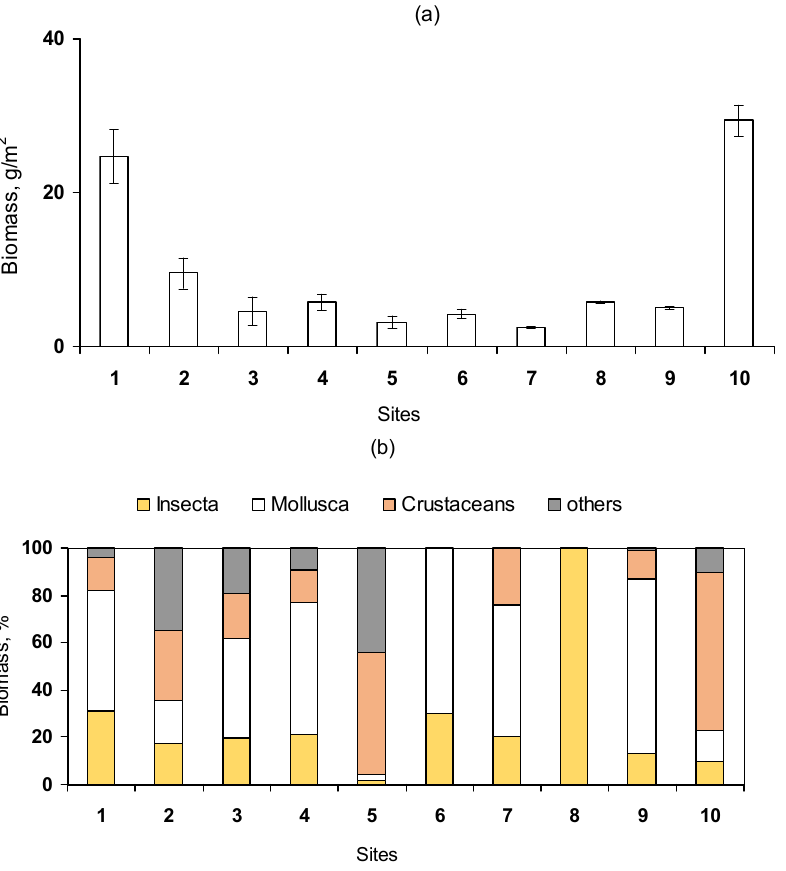
Figure 4. Biomass of macrozoobenthos g WW/m 2 , mean ± 1SE, n = 3 ( a ) and percentage contribution of the most abundant taxa to the total biomass ( b ) at study sites.